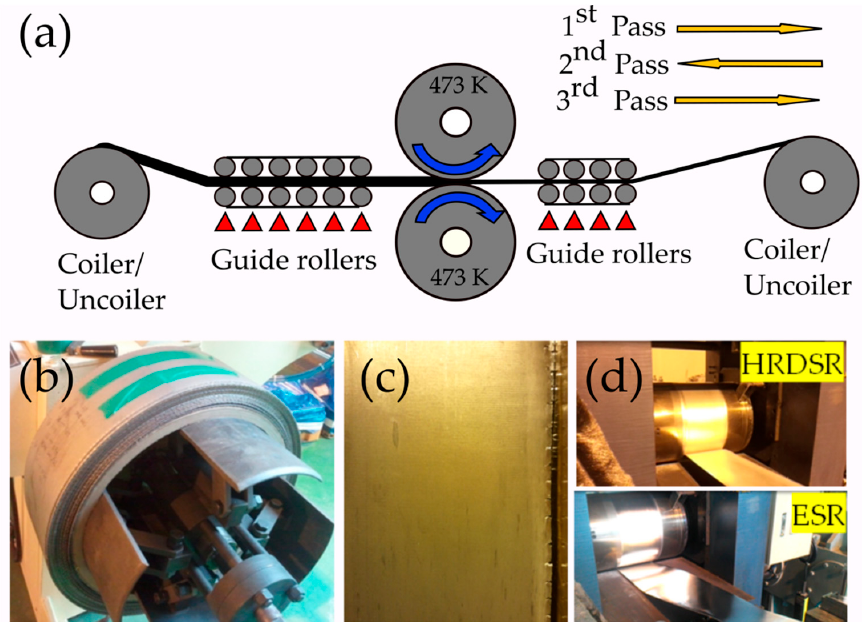
Figure 2. ( a ) The schematic of continuous high-ratio differential speed rolling (HRDSR) mill. ( b ) The coiled AZ31 magnesium alloy sheet processed after HRDSR and ( c ) the appearance of HRDSR-processed sheet and ( d ) HRDSR and equal speed rolling- (ESR)-processed AZ31 magnesium alloy sheets